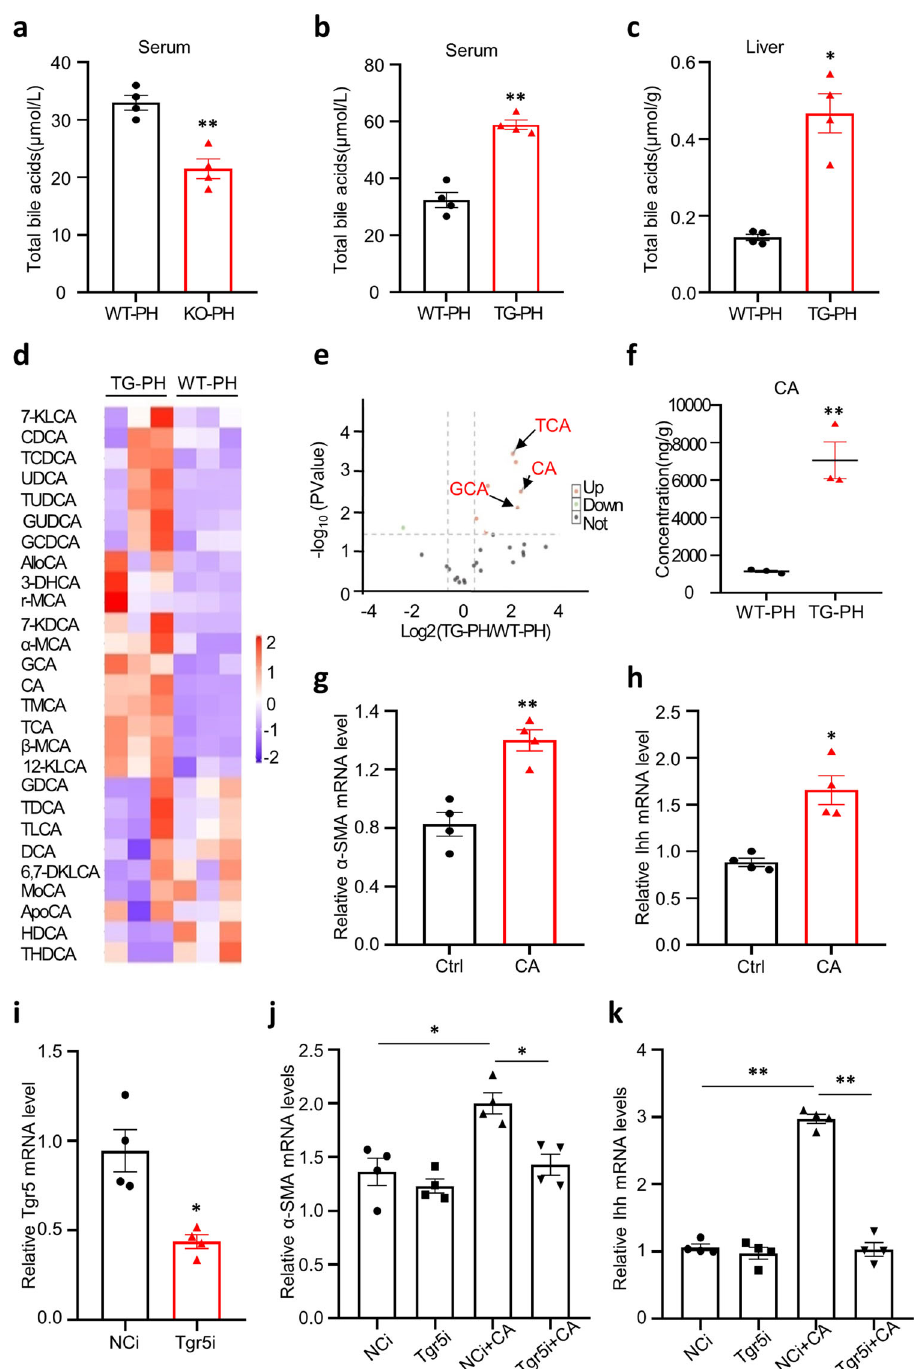
Fig. 6 miR-182-5p promotes hepatocyte proliferation by enhancing cholic acid (CA)-mediated activation of HSCs. a Total bile acid levels were measured in the serum of miR-182-5p KO and WT mice (3d after PH; n = 5/group). b , c Total bile acid levels were measured in the serum and liver of the miR-182-5p TG mice and their control mice(WT) at day 3 after 2/3 PH ( n = 4/group). d Heatmap showing changes in the abundance of BAs composition in liver of TG and WT mice (3d after PH). Blue represents down-regulation while a red represents upregulation. e Volcano plot of the BAs composition. Red, signi fi cantly increased gene expression; green, signi fi cantly decreased; gray, no statistical differences. f LC/MS analyses of the CA level in liver of the miR-182-5p TG mice and their control mice (WT) at day 3 after 2/3 PH ( n = 3/group). g , h qRT-PCR analyses of α -SMA and Ihh genes expression in primary HSCs by CA treatment ( n = 4/group). CA treated primary HSCs which were transfected with Tgr5 siRNA or NCi. i qRT-PCR analyses of Tgr5 gene expression in primary hepatic stellate cells. j , k qRT-PCR analyses of α -SMA and Ihh genes expression in primary HSCs ( n = 4/group). Error bars in all experiments represent SEM; Signi fi cance was determined by unpaired two-tailed Student ’ s t test and by one-way ANOVA. * P < 0.05, ** P <